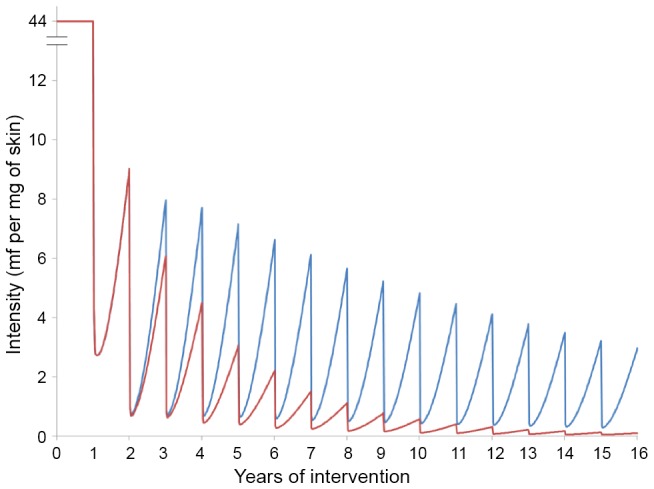
Impact on infection intensity of annual ivermectin distribution under two assumptions of ivermectin effects.Intensity of infection is quantified as microfilarial load per mg of skin in those aged ≥20 years. The red and blue solid lines represent, respectively, model outputs assuming the operation of a cumulative impact on the fertility of O. volvulus (illustrated in Fig. 1A), or the absence of such an effect (Fig. 1B). Model calibration corresponds to an ABR of 19,000 (savannah) Simulium damnosum bites/person/year; a baseline mean microfilarial load of 44 mf/mg (in those aged ≥20 years); a 70% microfilarial prevalence (all ages); a therapeutic coverage of 80% (overall population); and a systematic non-compliance rate of 0.1%. The demography of the human population is that of northern Cameroon [30], [37], [38].